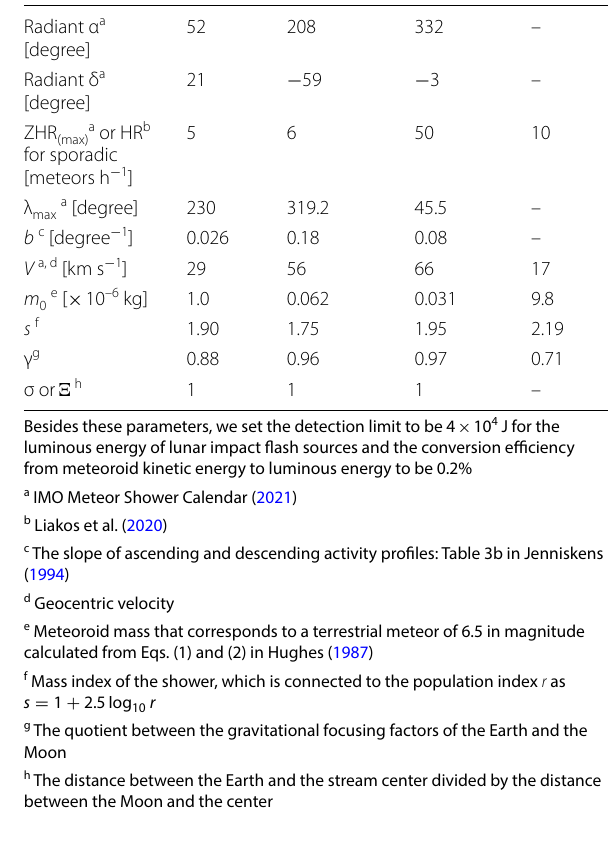
Table 5 Parameters of meteoroid streams